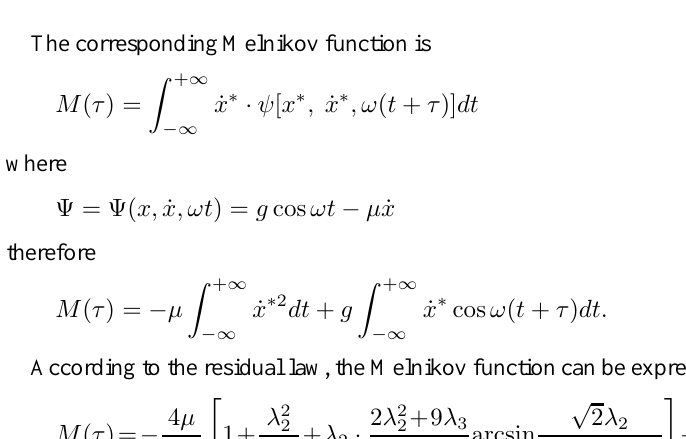
Fig. 2. Sketch of chaos